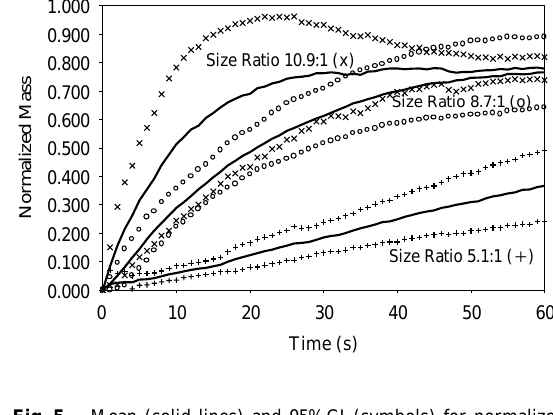
Fig. 5 Mean (solid lines) and 95% CI (symbols) for normalized mass as a function of time (cid:4) Strain (cid:6) 15%, Cycle Speed (cid:6) 0.75 cycles/second and Bed Depth (cid:6) 2.54